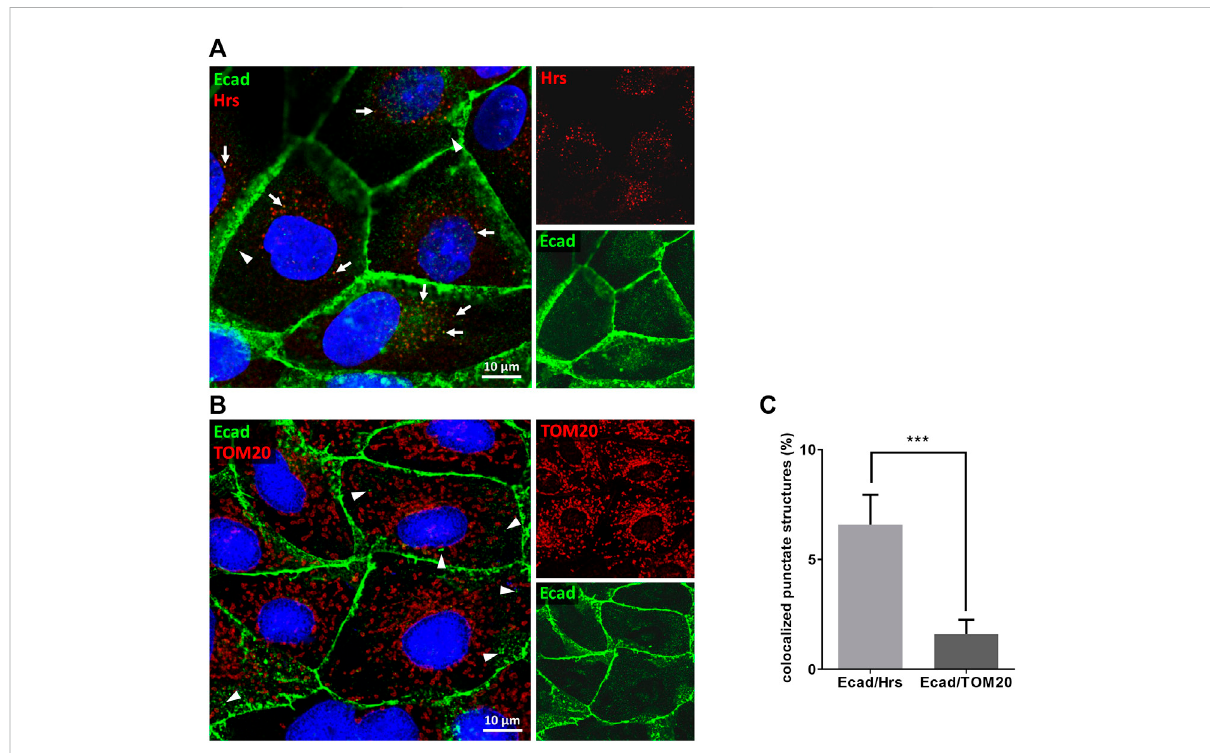
FIGURE 2 E-cadherin colocalizes with Hrs in MDCK cells. Confocal codistribution analysis of immunostained E-cadherin with the MVE-protein Hrs (A) or mitochondrialoutermembraneproteinTOM20 (B) .MDCKcellswerecultivatedfor2 days, fi xedandstainedbyimmuno fl uorescencewithmAbanti- E-cadherin/Alexa Fluor 555 and pAb anti-Hrs/Alexa Fluor 647 or pAb anti-TOM20/Alexa Fluor 647. Nuclei are depicted in blue. Co-stained vesicular structuresareindicatedbyarrows.ArrowheadspointatpunctateE-cadherin-positivestructuresthatarenotco-stainedwithHrsorTOM20. (C) Manders ’ correlation coef fi cient was used for quanti fi cation of experiments. Means ± s.e.m., 15 – 20 cells per experiment, n = 3 independent experiments. Nuclei were excluded from quanti fi cation. Statistical analysis in this fi gure: Student ’ s unpaired t -test, *** p <